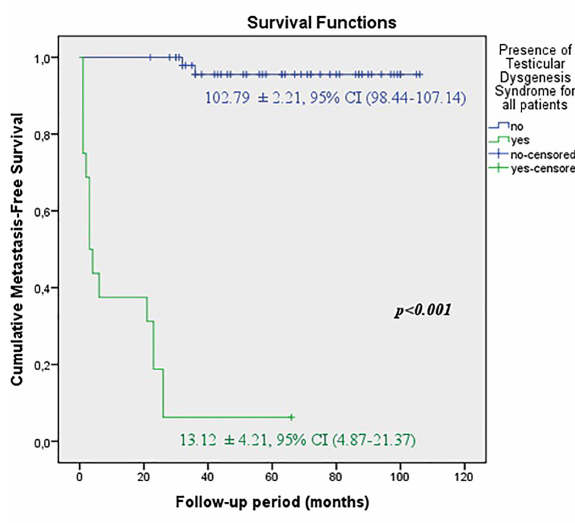
Figure 2B - Kaplan-Meier plots of metastasis-free survival according to presence of Testicular Dysgenesis Syndrome for all